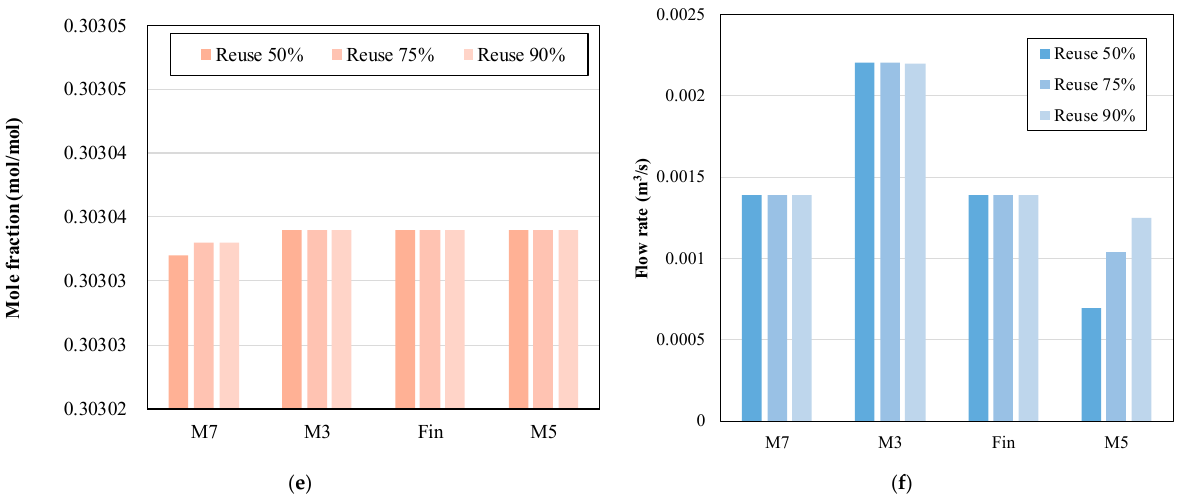
Figure 7. Simulation results of concentration and flow rate at each point; ( a ) CH 4 , ( b ) CO, ( c ) N 2 , ( d )H 2 O, ( e ) CO 2 , ( f ) Flow rate.